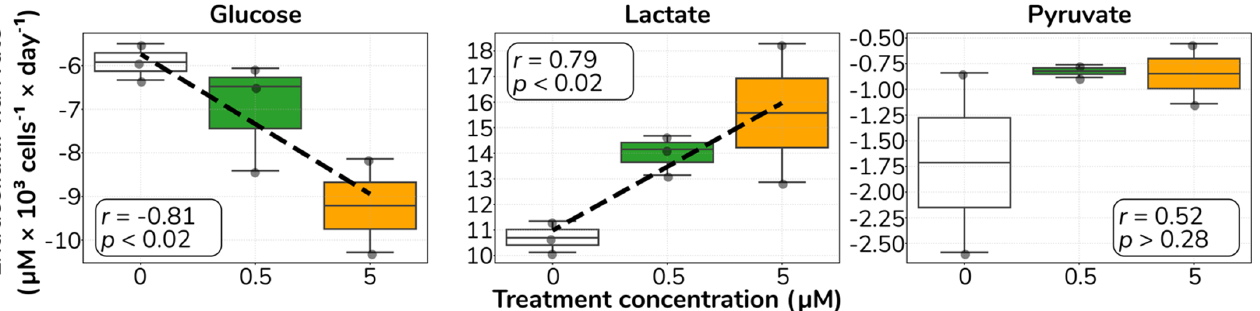
Figure 2. Catecholamine stimulation increases glucose uptake and lactate secretion. Distribution of measured extracellular transport rates for glucose, lactate and pyruvate. Positive rates indicate secretion; negative rates indicate uptake. Dashed lines denote significant correlations. White inner boxes display Pearson correlation coefficient ( r ) and p value ( p ).